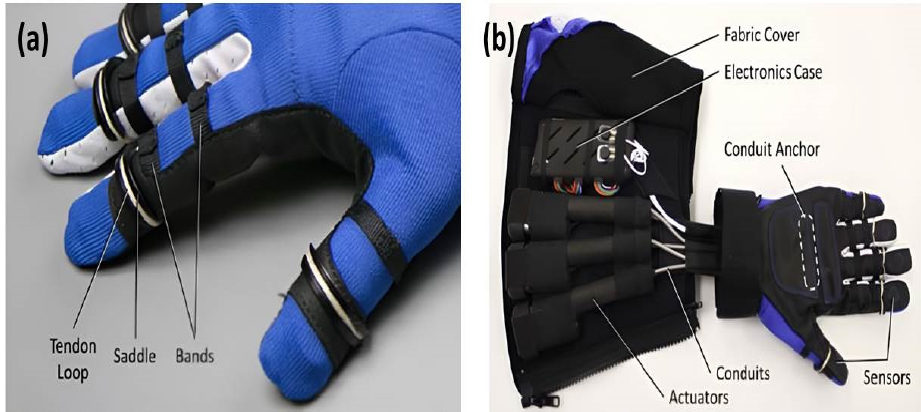
Figure 4. ( a ) A mechanical glove, Robo-Glove, with pressure sensors and other sensors jointly developed by General Motors and NASA. ( b ) The back and details of the mechanical glove [69].